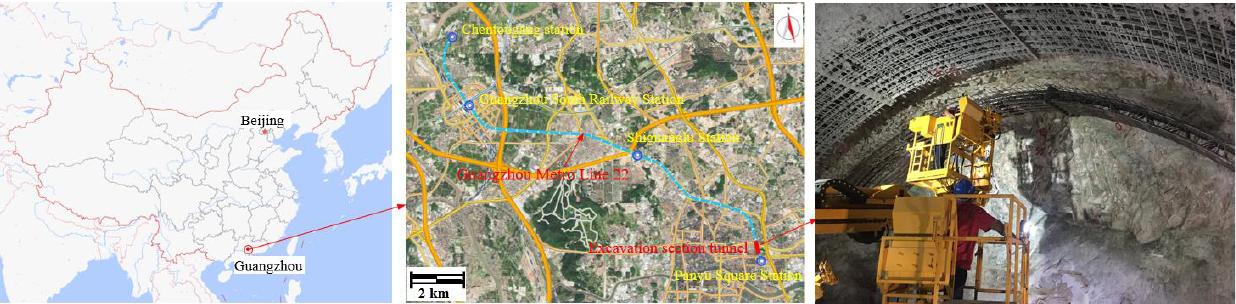
Figure 22. The geographical location of the underground tunnel project in the urban area in Guangzhou, China.